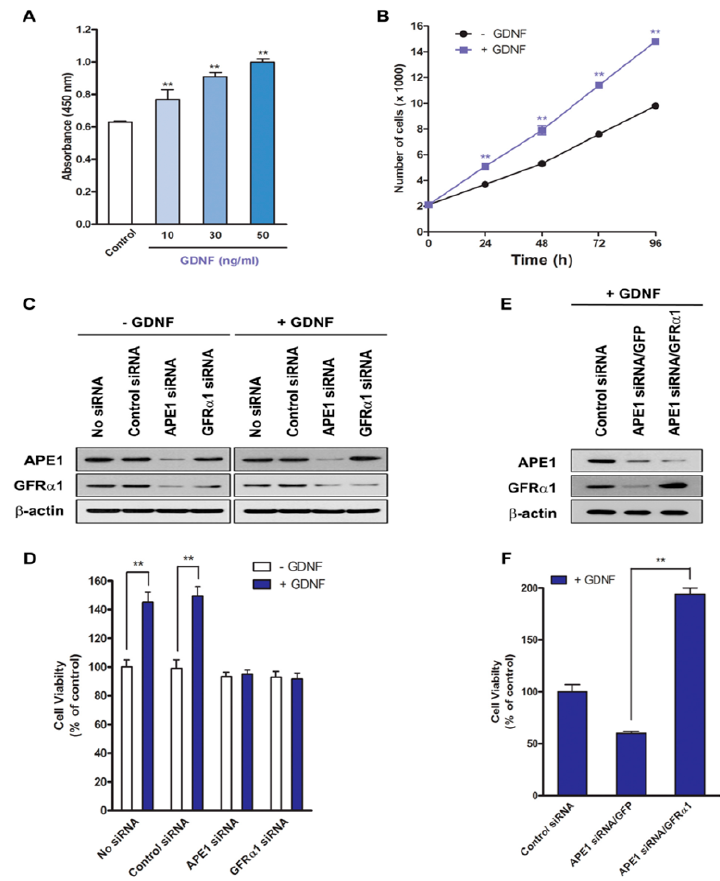
Figure 1. APE1 promotes pancreatic cancer cell proliferation via GFR α 1. ( A ) MIA PaCa-2 cells were incubated with GDNF for 24 h. Cell proliferation was analyzed by WST-1 assay. The values are represented as a mean ± standard deviation from three independent experiments. ** Denotes p < 0.01 by t -test for equality of means. ( B ) MIA PaCa-2 cells were incubated with or without GDNF (50 ng / mL) for up to 96 h. The number of cells was determined by BrdU assay every 24 h after GDNF treatment. The values are represented as a mean ± standard deviation from three independent experiments. ** Denotes p < 0.01 by t -test for equality of means. ( C and D ) MIA PaCa-2 cells were transfected with control siRNA, APE1 siRNA, or GFR α 1 siRNA. After transfection, the cells were treated for 48 h with or without 50 ng / mL GDNF. ( C ) Western blot analysis of APE1 and GFR α 1. ( D ) Cell proliferation was analyzed by WST-1 assay. The results indicate the percentage of cell proliferation compared with untreated controls (adjusted to 100%) from three independent experiments. ** Denotes p < 0.01 by t -test for equality of means. ( E and F ) Control siRNA (scrambled) or APE1 siRNA-transfected MIA PaCa-2 cells were cultured and transduced with either control GFP or GFR α 1 lentivirus. After transfection, the cells were treated for 48 h with or without 50 ng / mL GDNF. ( E ) Western blot analysis of APE1 and GFR α 1. ( F ) Cell proliferation was analyzed by WST-1 assay. The results indicate the percentage of cell proliferation compared with untreated controls (adjusted to 100%) from three independent experiments. ** Denotes p < 0.01 by t -test for equality of